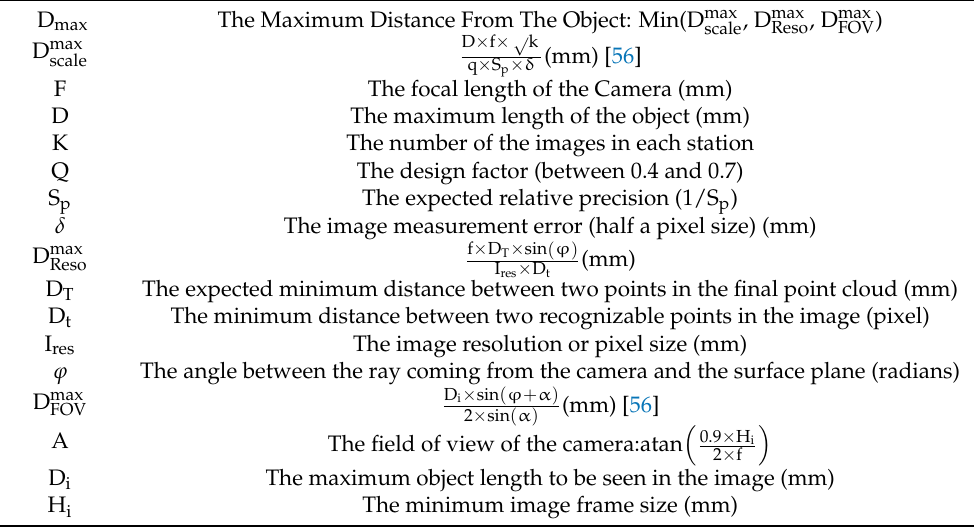
Table 1. The equations for estimating the maximum distance from the building.